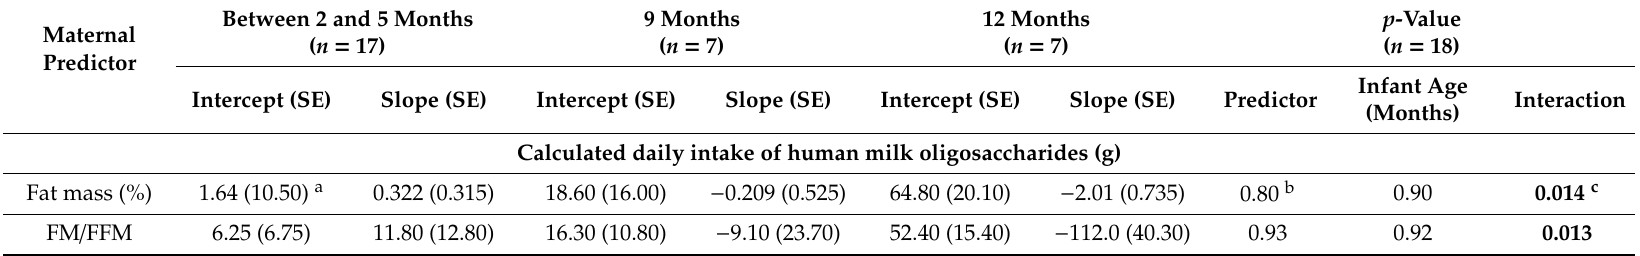
Table A1. Associations between maternal characteristics and calculated daily intakes of human milk